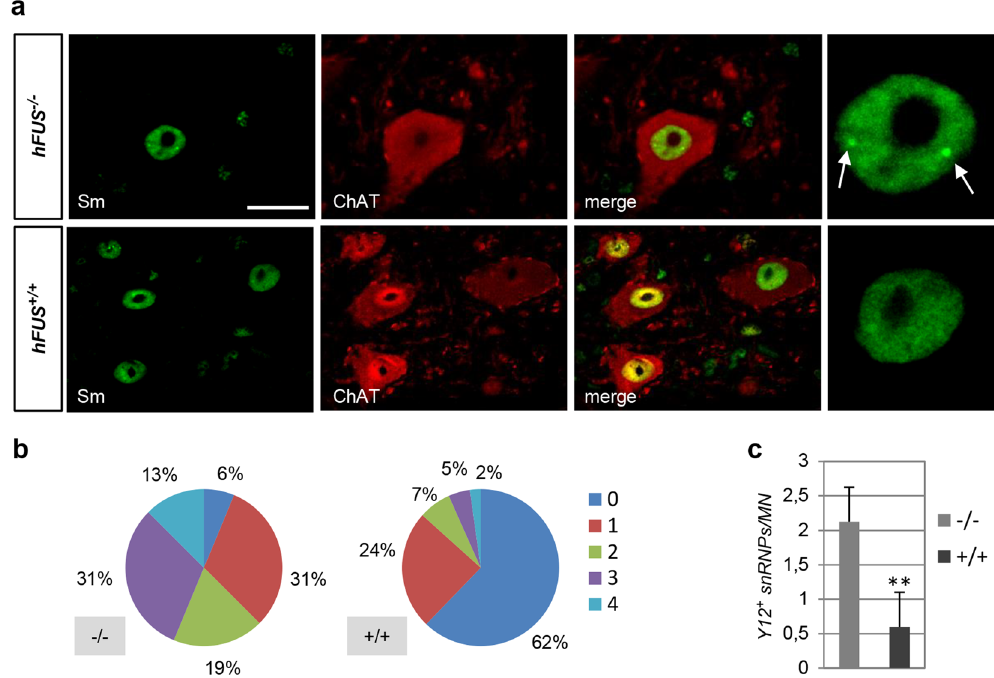
Figure 2. hFUS + / + mice show decreased number of mature snRNPs. ( a ) Lumbar spinal cords from hFUS − / − and hFUS + / + mice (40 days) were stained with the Y12 antibody to detect Sm proteins and with an anti-ChAT antibody to detect motor neurons. Magnifications are show to highlight the presence of Y12-positive nuclear dots (arrows) corresponding to mature snRNPs. Scale bar: 20 μ m. ( b ) Distribution of motor neurons (%) classified according to the number of Y12-positive (Y12 + ) snRNPs per nucleus. ( c ) Mature snRNPs per motor neuron were scored and the means ± SD are reported. At least 100 motor neurons for each genotype were